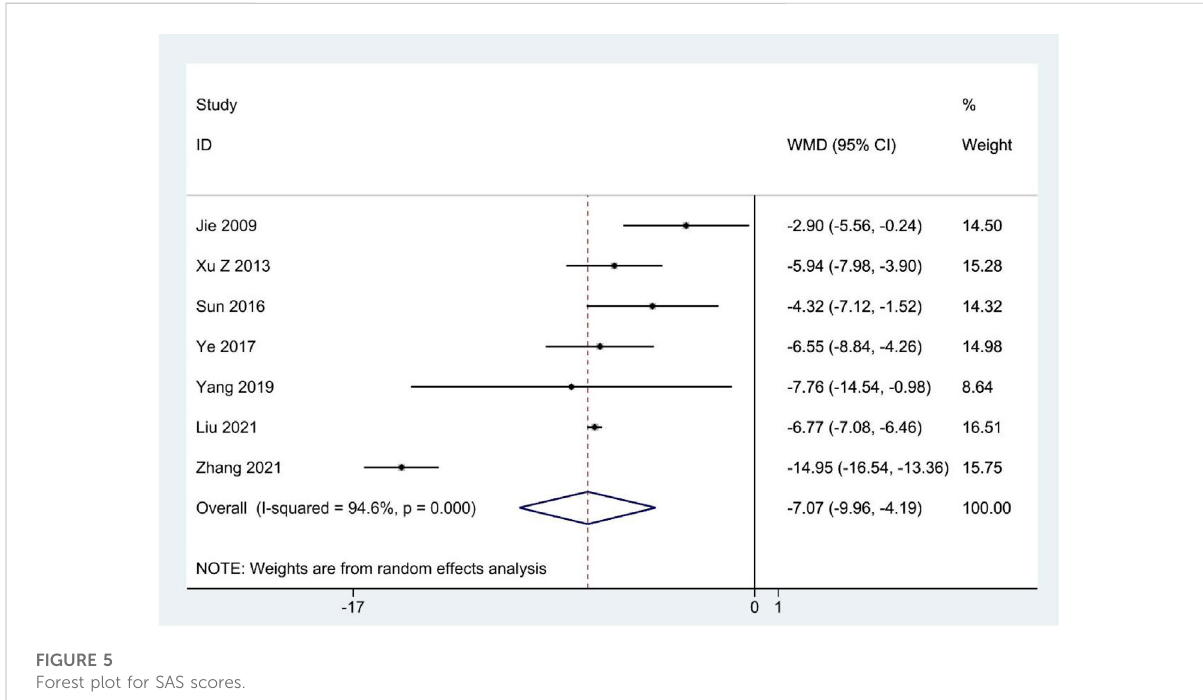
FIGURE 5 Forest plot for SAS scores.